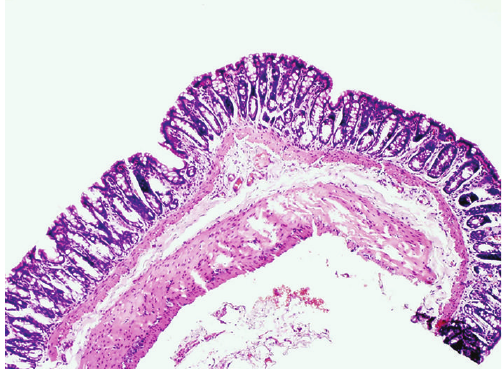
Figure 4: Dysplastic lesion in chronic inflamed colonic mucosa from a rat in the DSS group.